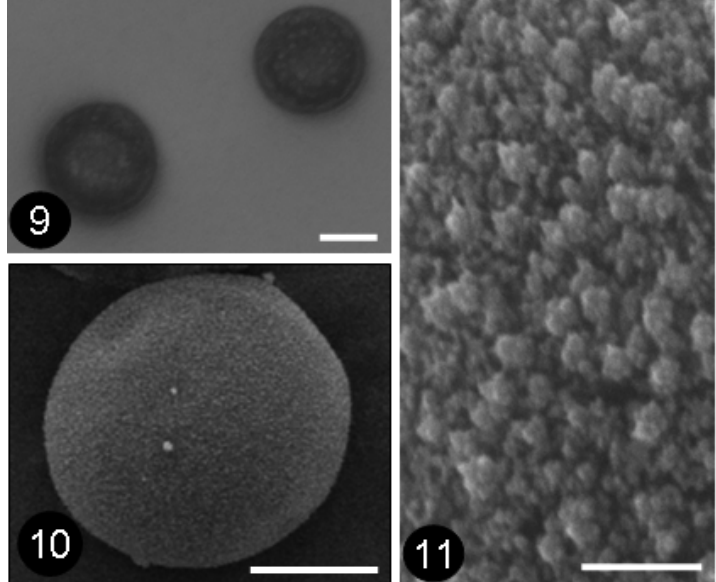
Fig. 9 – Pollen grain visualized under stereomicroscope magnified 100 × . Scale bar = 25 μ m. Fig. 10 – Pollen grain visualized through SEM magnified 400 × . Scale bar = 25 μ m. Fig. 11 – Detail of the pollen grain surface (exine) visualized through SEM magnified 8000 × . Scale bar = 2 μ